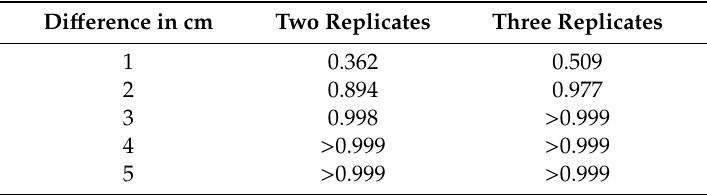
Table 2. Power for the trait length of the third